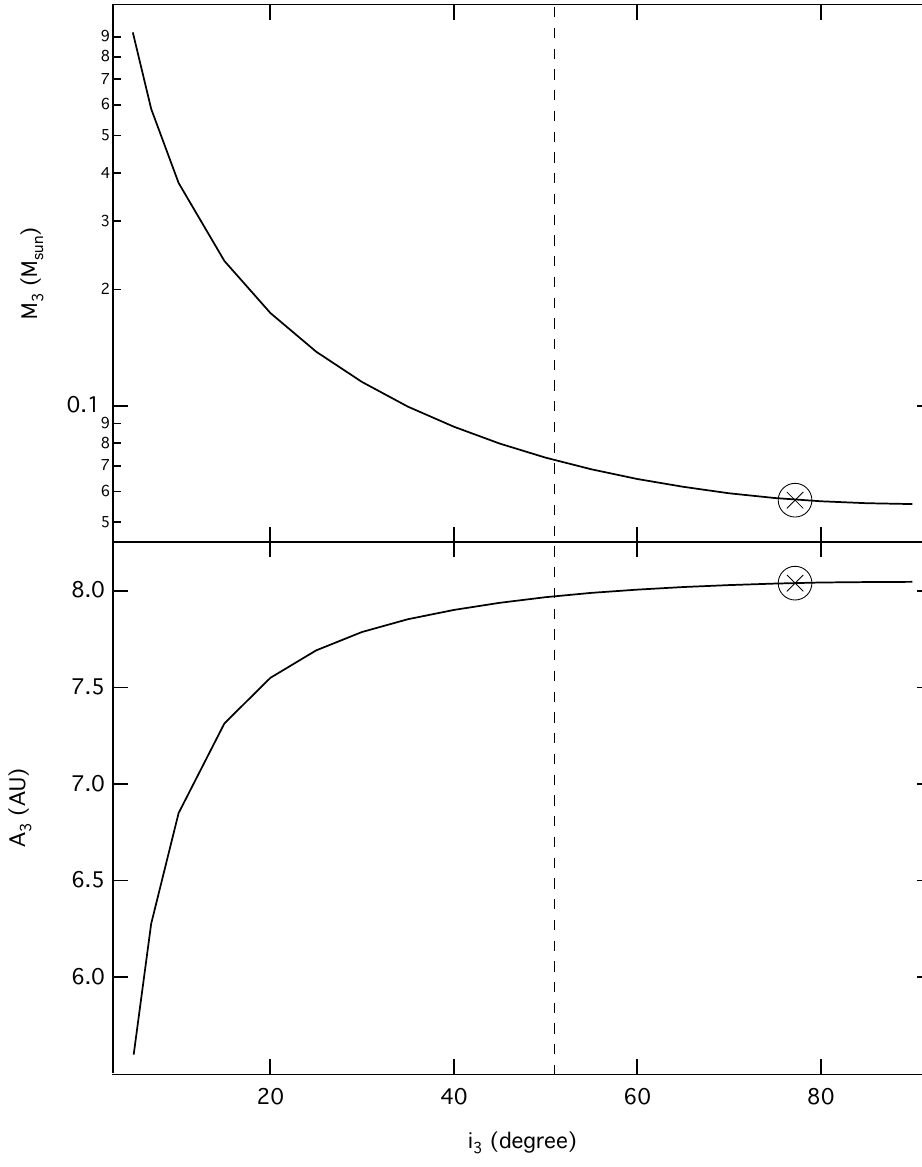
Figure 4. Masses and separations of the third component in RW Tri depending on the different orbital inclination are plotted in the upper and lower panels, respectively. The cross denotes the mass and separation of a brown dwarf hidden in a coplanar orbit of RW